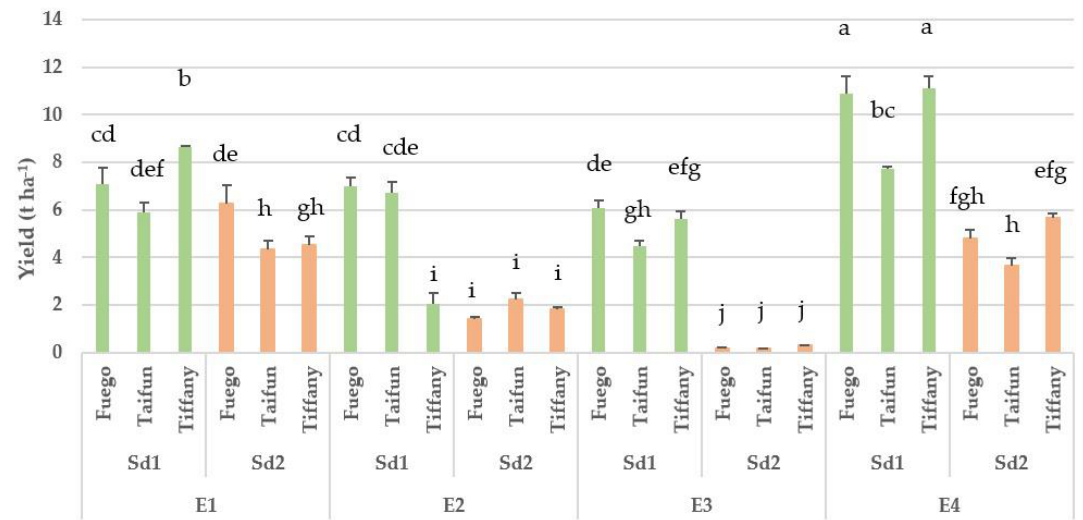
Figure 2. Interaction between faba bean cultivars with different sowing dates under different environments for seed yield. SD1: early sowing date and SD2: late sowing date. E1, E2, E3, and E4 represent the different environments (see Table 2 for more details). Values (means ± SE, n = 3). Means followed by different letter in each bar plot are significantly different according to the Tukey’s post hoc test ( p = 0.05).